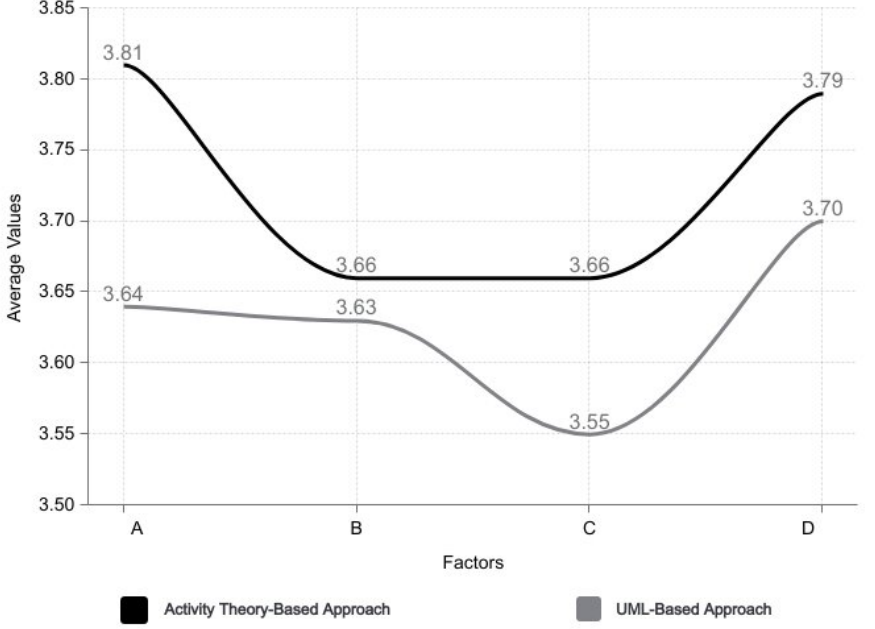
Figure 6. Final average values for the reviewed approaches regarding the measurement factors.